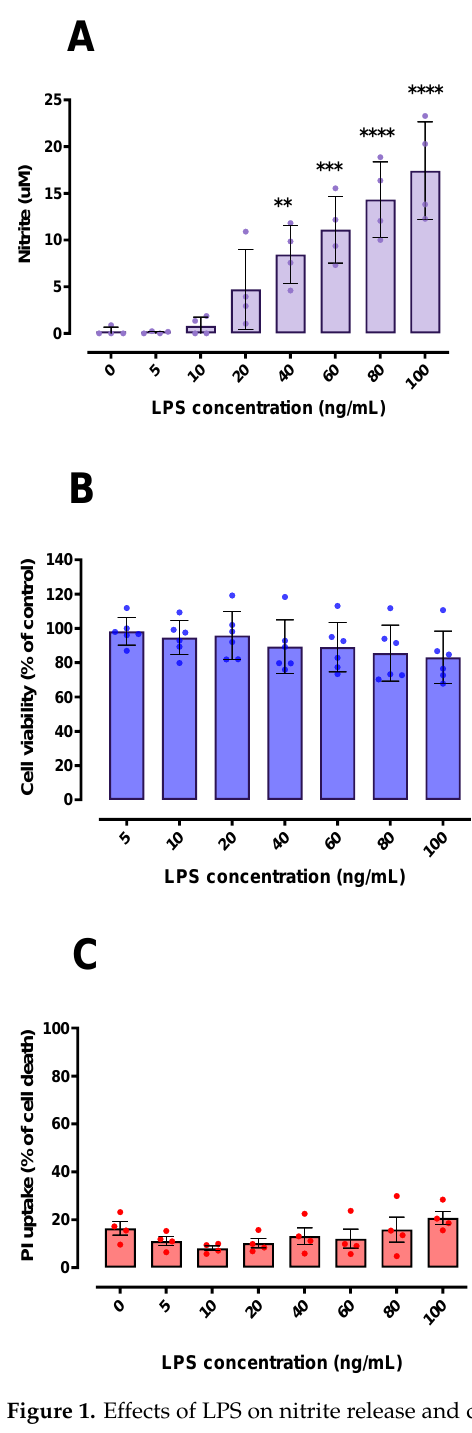
Figure 1. Effects of LPS on nitrite release and cell viability in BV-2 microglial cells. Concentration- dependent nitrite release from BV-2 cells was detected by the Griess method, suggesting microglial activation ( A ). BV-2 cell viability was not significantly affected by LPS exposure when compared to the control using MTT and PI assays ( B , C ). In ( C ), 100% cell death is represented by cells treated with 0.2% Triton X-100 for 20 min. ** p < 0.01; *** p < 0.001; **** p < 0.0001 in comparison with control group (untreated cells). ( A , C ) n = 4; ( B ) n =